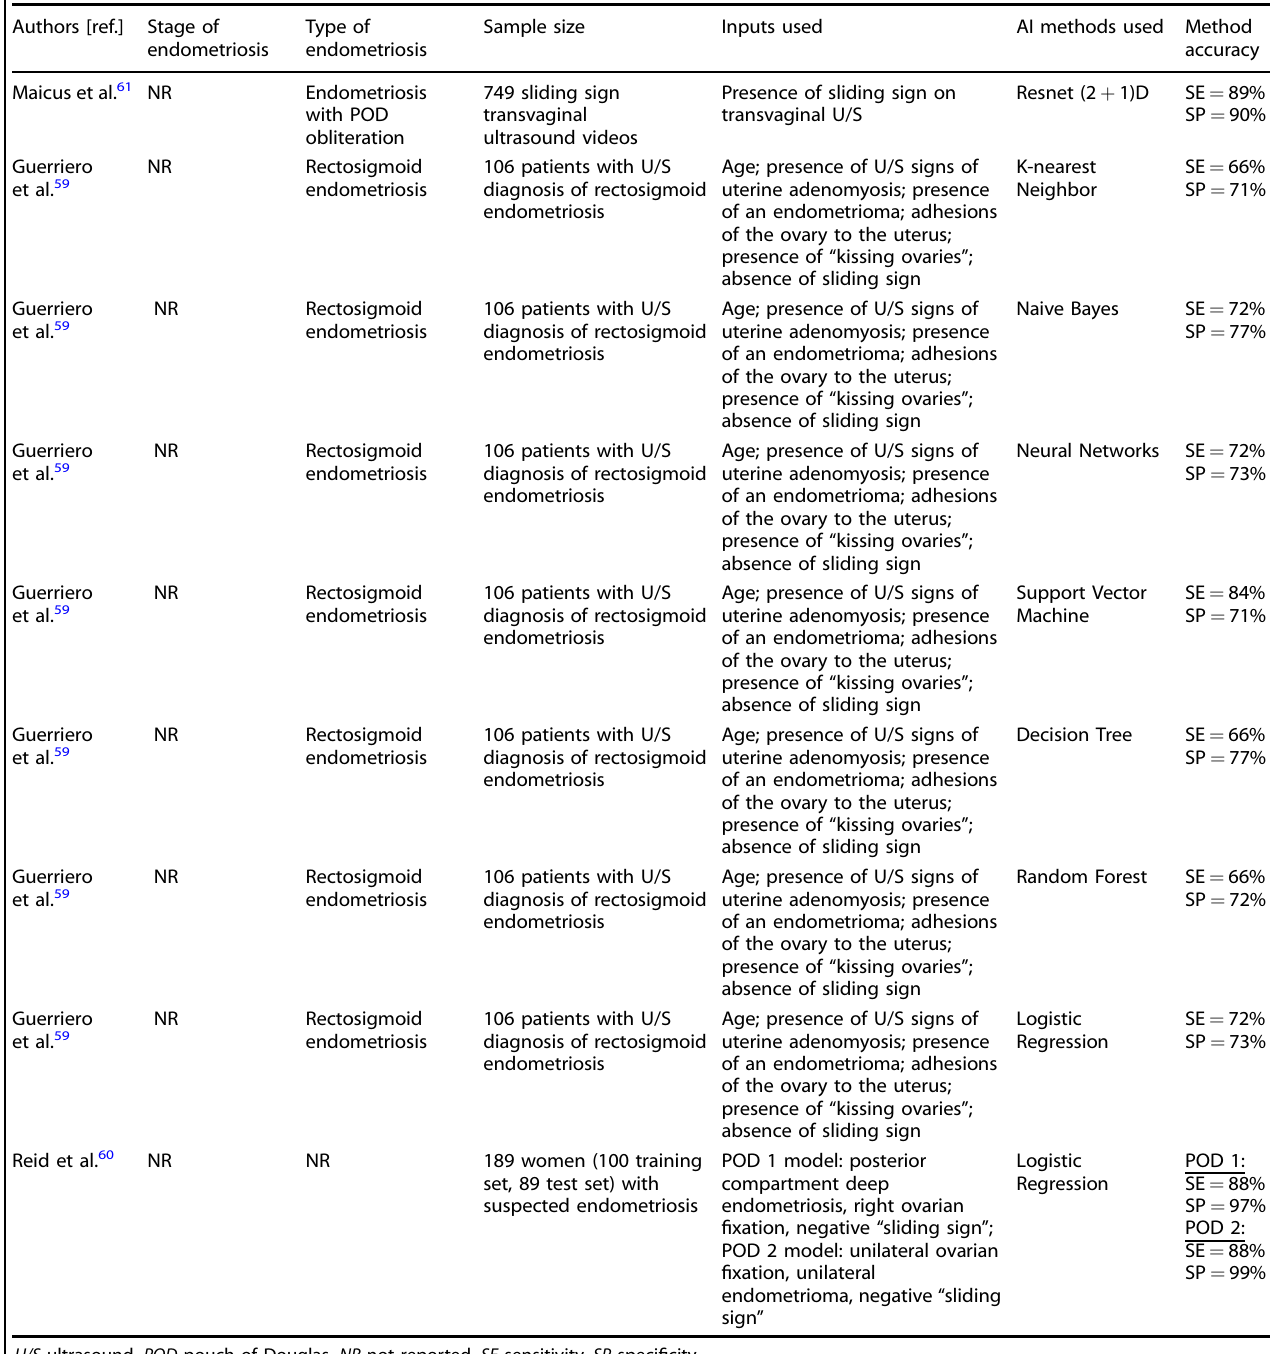
Table 7. Diagnostic and predictive models built using